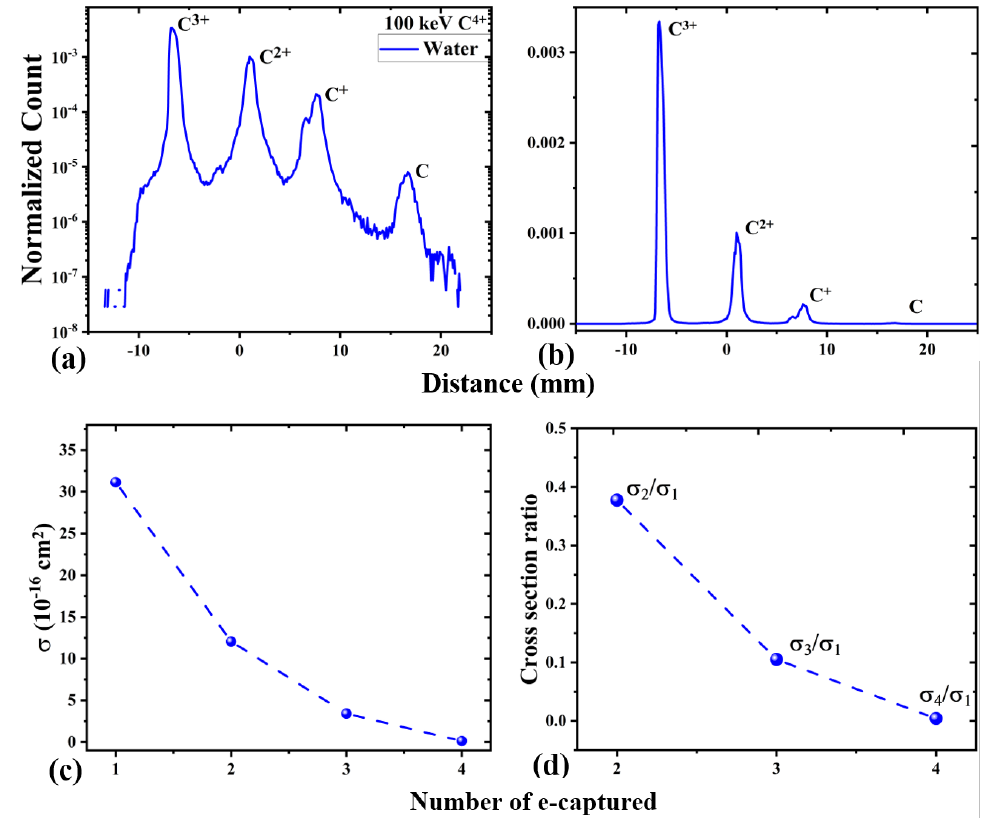
Figure 4. ( a ) Normalized counts with distance on position sensitive detector, for 100 keV C 4+ collisions with water, showing distinct peaks of C, C + , C 2+ , and C 3+ capture channels. ( b ) The same data are shown in a linear scale. ( c ) Cross-section for different electron capture channels with number of captured electrons. ( d ) The ratio of multi-capture to single capture cross-section for 100 keV C 4+ beam. Dashed lines are guides to the